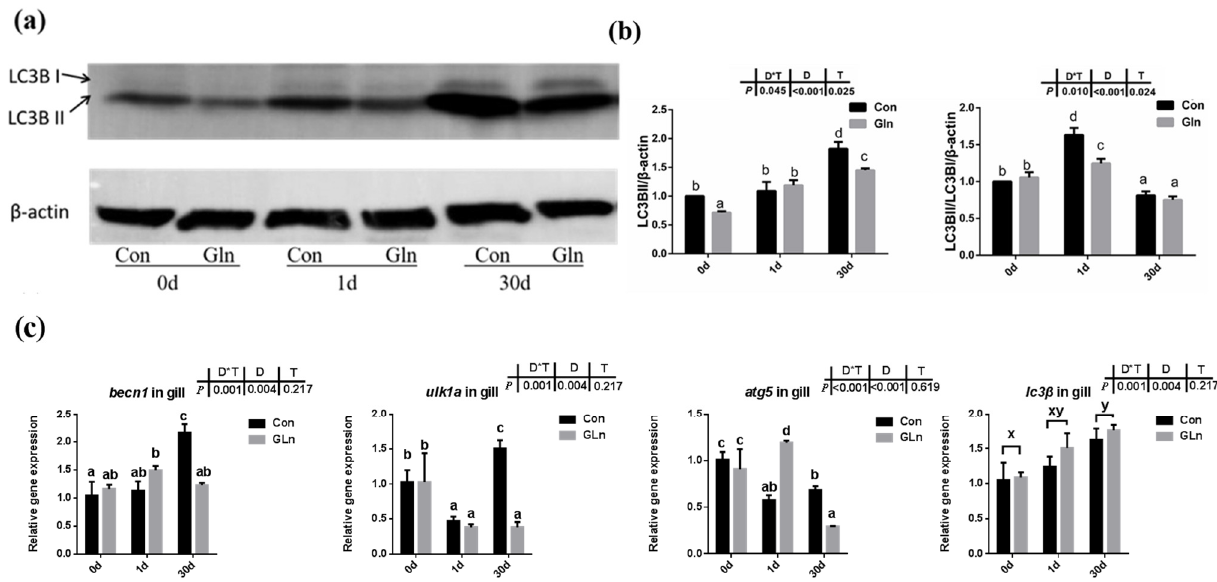
Figure 6. The effects of dietary glutamine on the autophagy of yellow catfish during F. columnare infection. ( a ) Western blotting analysis of LC3B I and LC3B II in yellow catfish in both control group (Con) and glutamine supplementation group (Gln) at 0 d, 1 d and 30 d after F. columnare infection. ( b ) The ratio of LC3B II protein level/ β -actin protein level and the ratio of LC3B II/LC3B I/ β -actin protein level in yellow catfish among all treatments ( n = 6). ( c ) The mRNA expression of becn1 , ulk1a , atg5 and lc3 β in the gill of yellow catfish among all treatments. All data were analyzed with two-way ANOVA and data are means ± SD ( n = 3). When significant D*T were observed ( p < 0.05), data